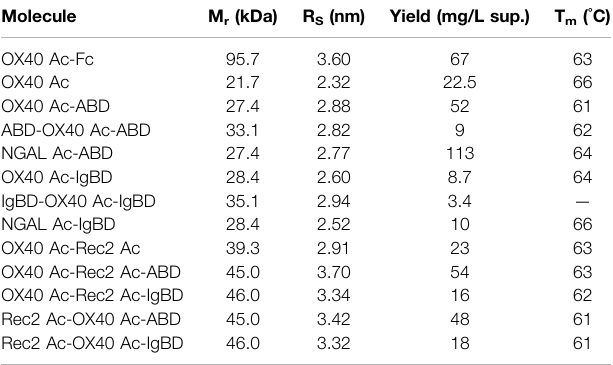
TABLE 1 | Biochemical properties of Anticalin proteins.